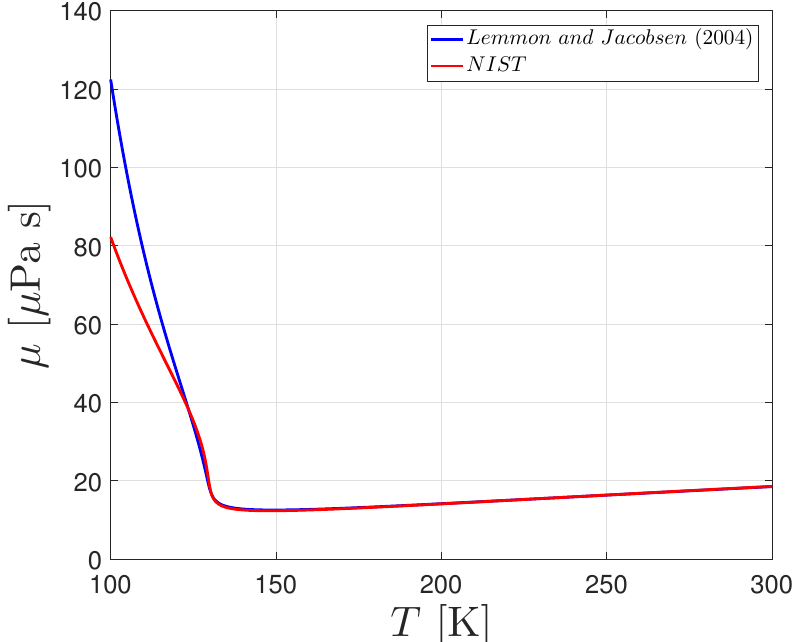
Figure 4. Validation of Lemmon and Jacobsen [57] dynamic viscosity model concerning the NIST database.